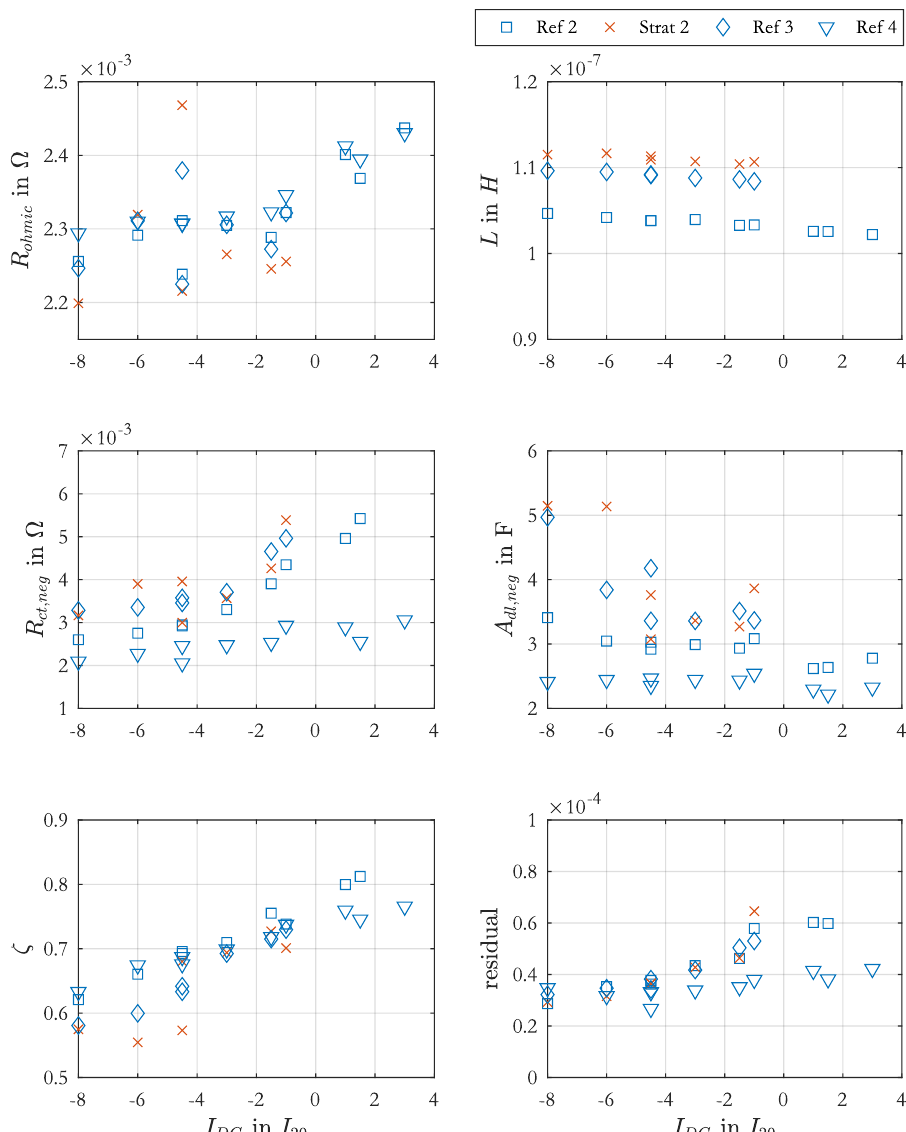
Figure 7. EEC element values together with the residual from fitting of the impedance spectra in EIS sets Ref. 2 , Strat. 2 , Ref. 3 and Ref. 4